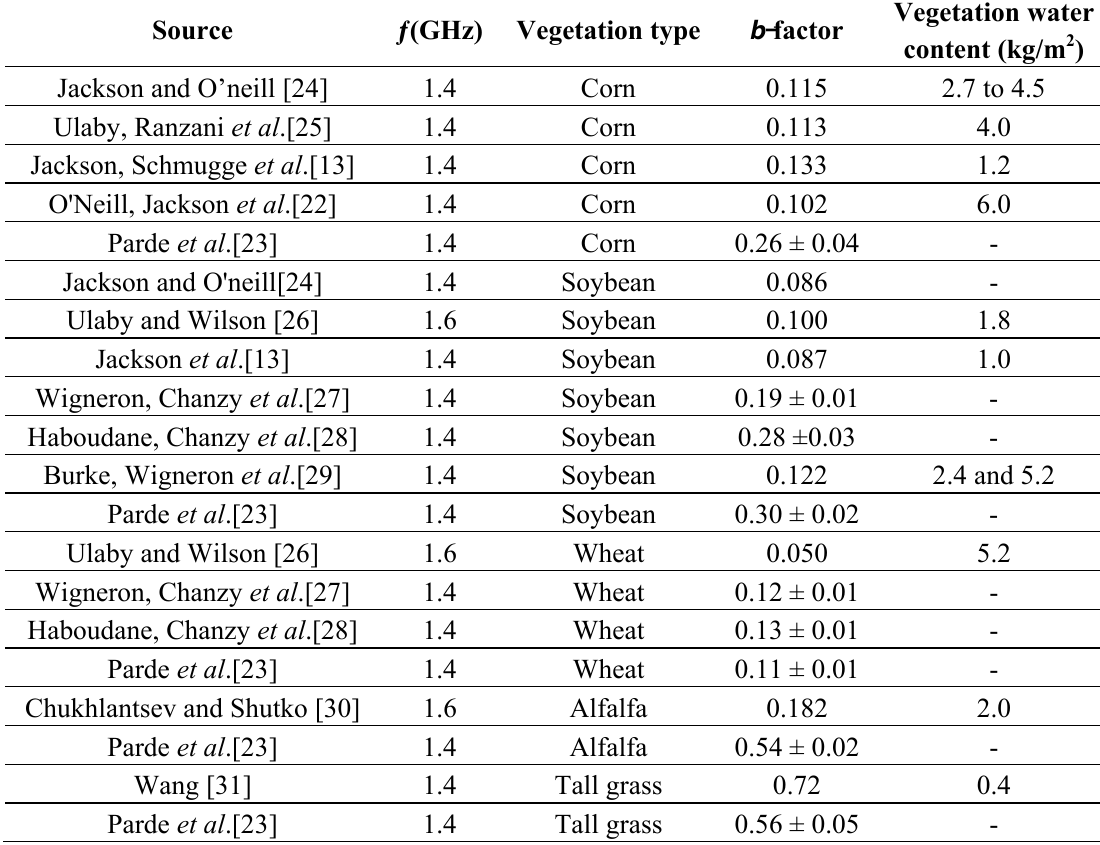
Table 4. The b- factor for different vegetation covers at L-band.